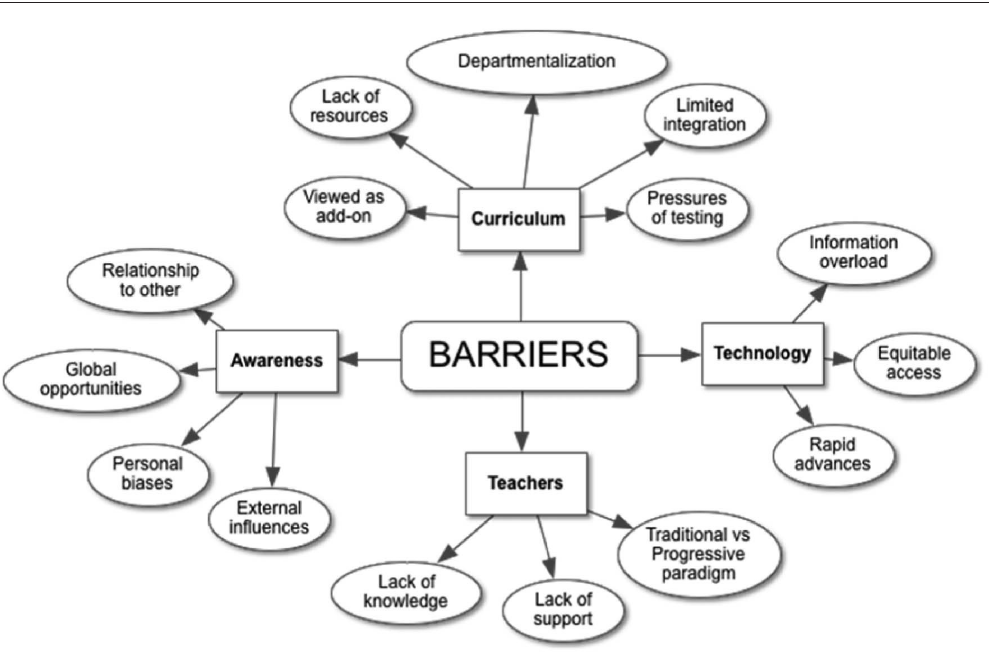
Figure 1: Barriers to teaching layered